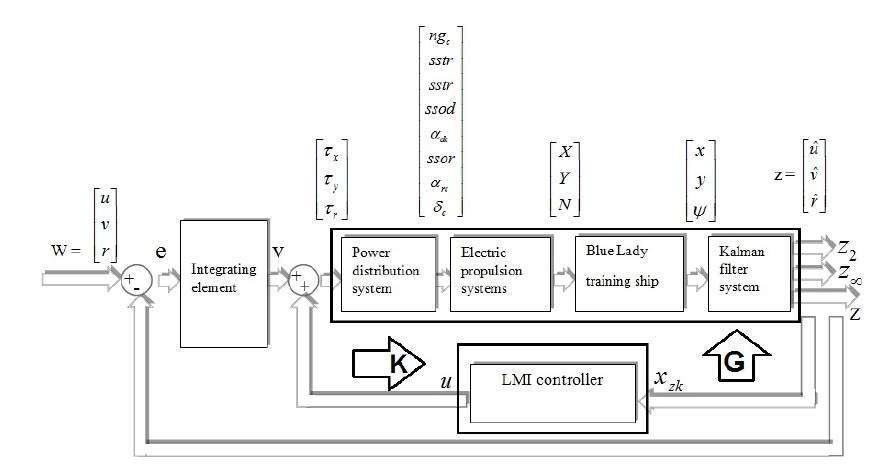
Figure 6. Simplified block diagram of the closed loop control